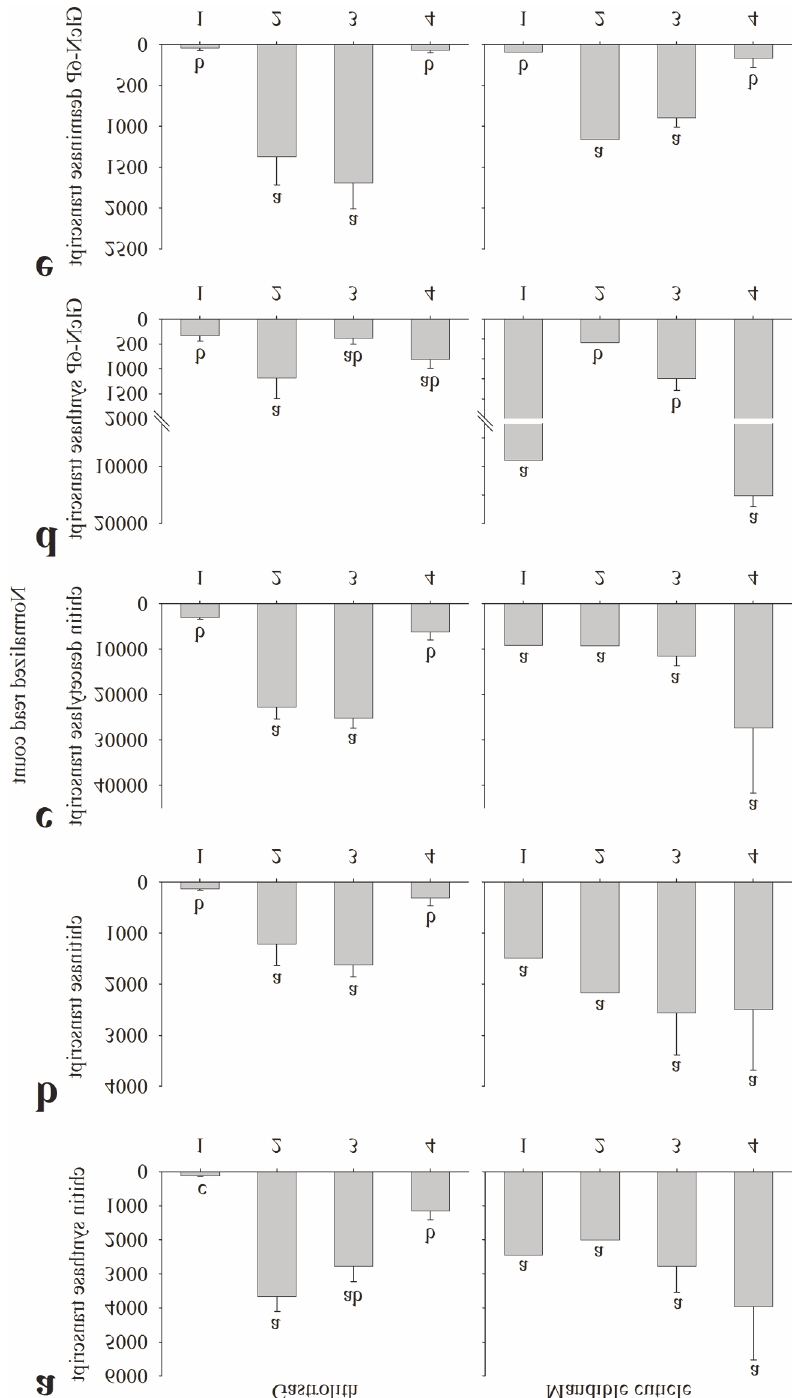
Fig 5. Normalized read count of key chitin metabolism-related genes transcripts. Read count of key chitin metabolism-related genes transcripts from the gastrolith-forming epithelium (left) and the mandible cuticle-forming epithelium (right). Numbers on the X axis represent the four molt stages, 1 inter-molt (pool of animals, n = 1), 2 early pre-molt (pool of animals, n = 1), 3 late pre-molt (two single animals and one pool, n = 3) and 4 post-molt (all single animals, n = 2). Presented transcripts are (a) chitin synthase, (b) chitinase, (c) chitin deacetylase, (d) GlcN-6P synthase and (e) GlcN-6P deaminase. Letters represent statistical groups which are significantly different ( p -value < 0.05), error bars represent standard